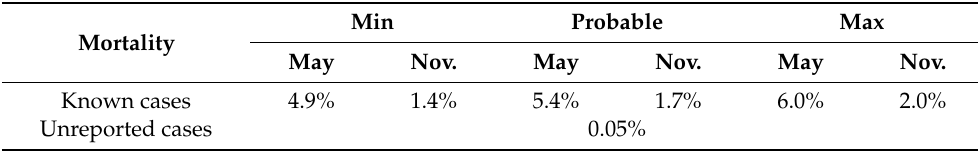
Table A12. Mortality in relation to the number of infected